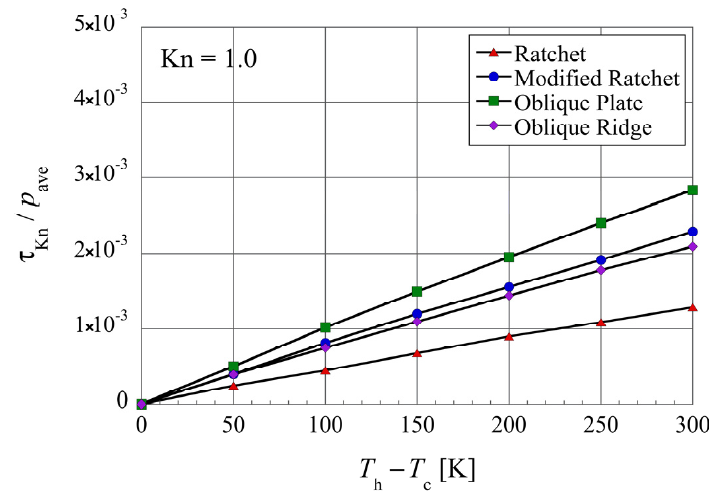
Figure 12. Net tangential Knudsen stresses, i.e., propulsive forces per unit area, for different surface microstructures at different temperature differences, in the case of Kn = 1 and ( T h + T c ) /2 = 400 K .